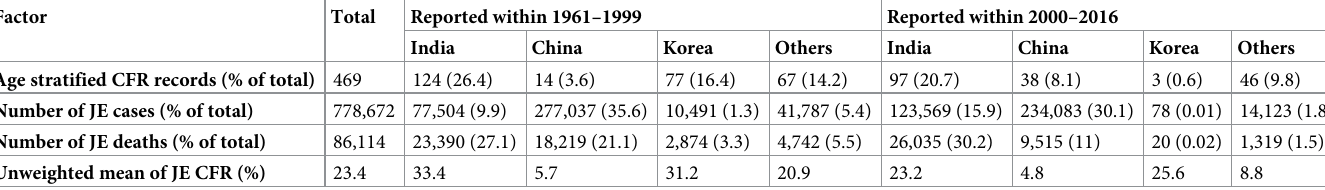
Table 1. Table of summary statistics of age-stratified Japanese encephalitis (JE) case-fatality observations obtained from the systematic review. Spatial and temporal distribution of the collected JE cases, deaths, and case-fatality ratios (CFR) were presented. India, Korea, and China were the top three countries with the most observed JE records. Other countries from which records were included are Bangladesh, Cambodia, Hong Kong, Indonesia, Japan, Malaysia, Myanmar, Nepal, Thailand, and Vietnam. The unweighted mean is the mean of the CFR calculated across all records in our dataset for a particular time period and country. Factor Total Age stratified CFR records (% of total)